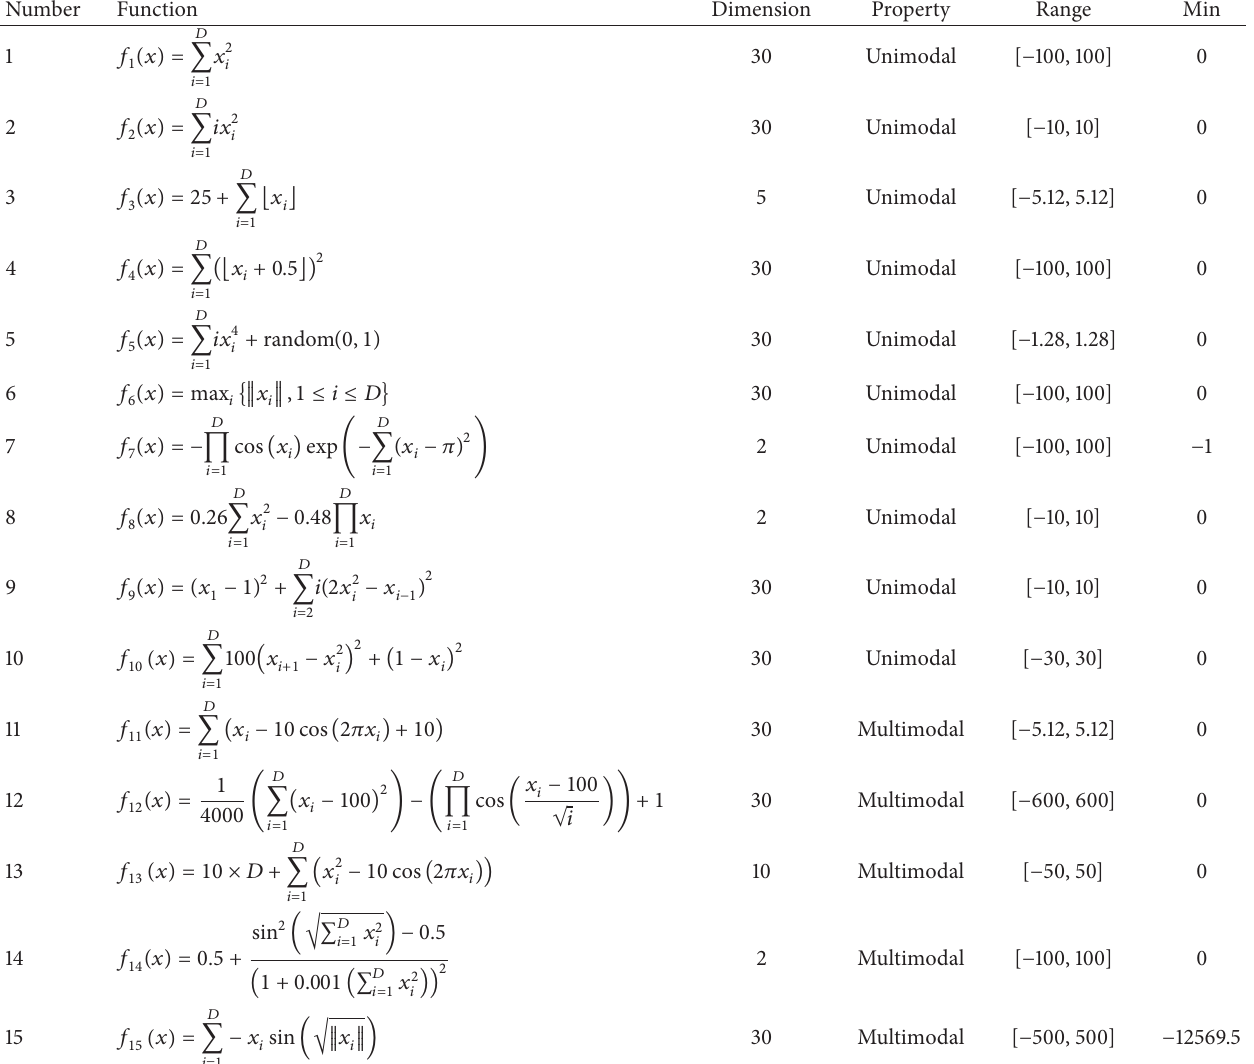
Table 1: Benchmark functions used in